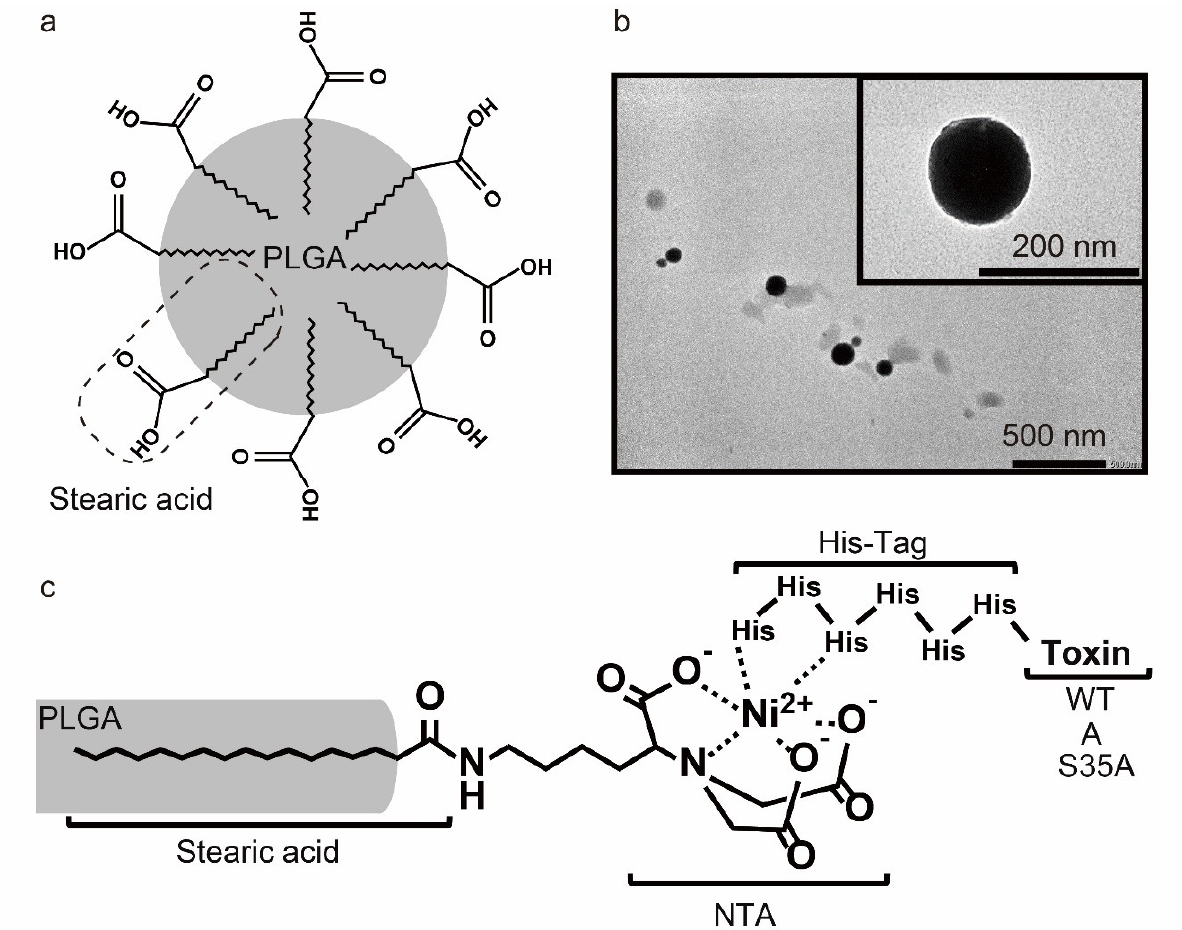
Figure 2. Preparation of PLGA NPs and modification with SubAB. ( a ) Schematic diagram of PLGA NPs in which stearic acids are anchored on the surface. ( b ) Transmission electron microscopy image of PLGA NPs. ( c ) Schematic diagram of toxin-PLGA NPs in which toxins are anchored on the surface. To evaluate pH-responsive dissociation of His-tagged SubAB toxins and SubA from PLGA NPs, we treated WT-, A-, and S35A-PLGA NPs with buffer solutions of different pH values as indicated in Figure S3. Most His-tagged toxins had dissociated within 1 min at pH 5.0, but not at pH 7.4 (Figure S3a–d). Recently, functional vesicular systems